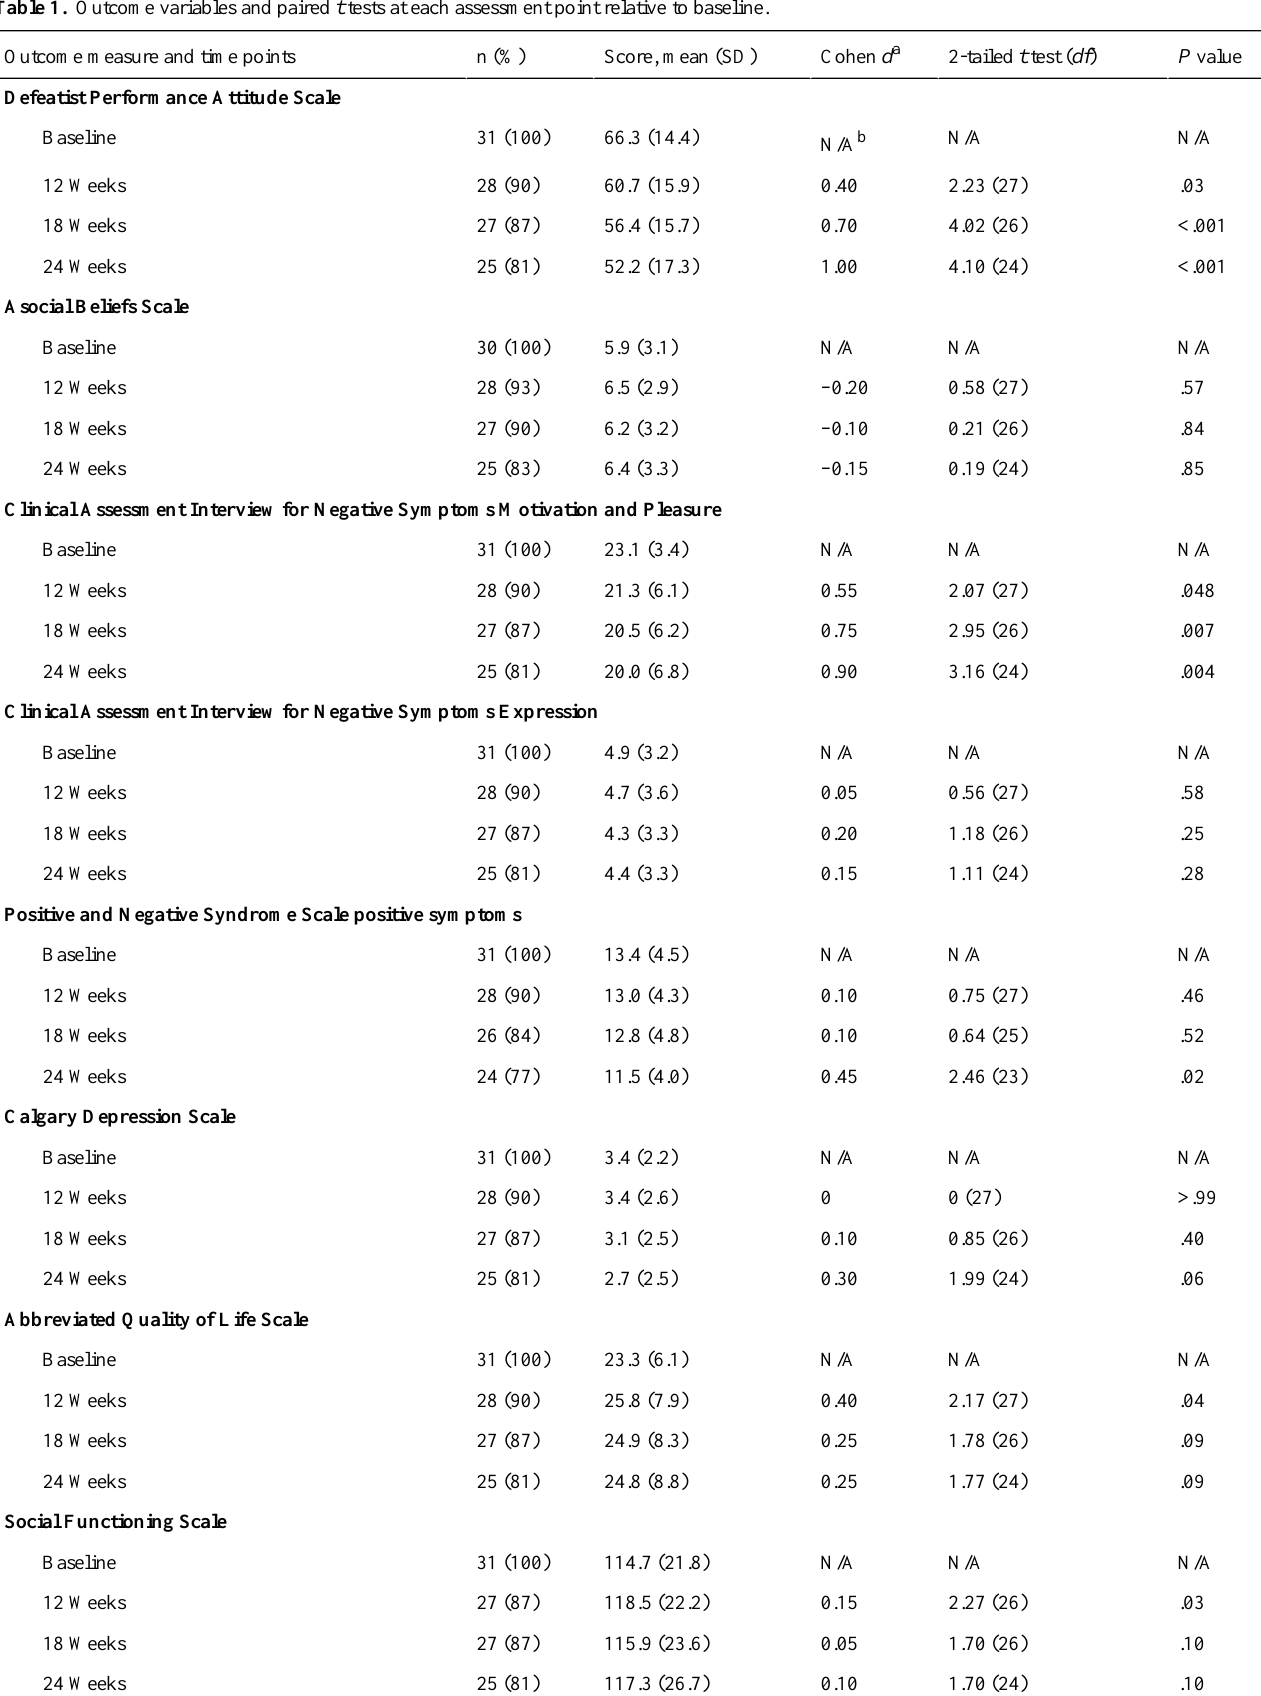
Table 1. Outcome variables and paired t tests at each assessment point relative to